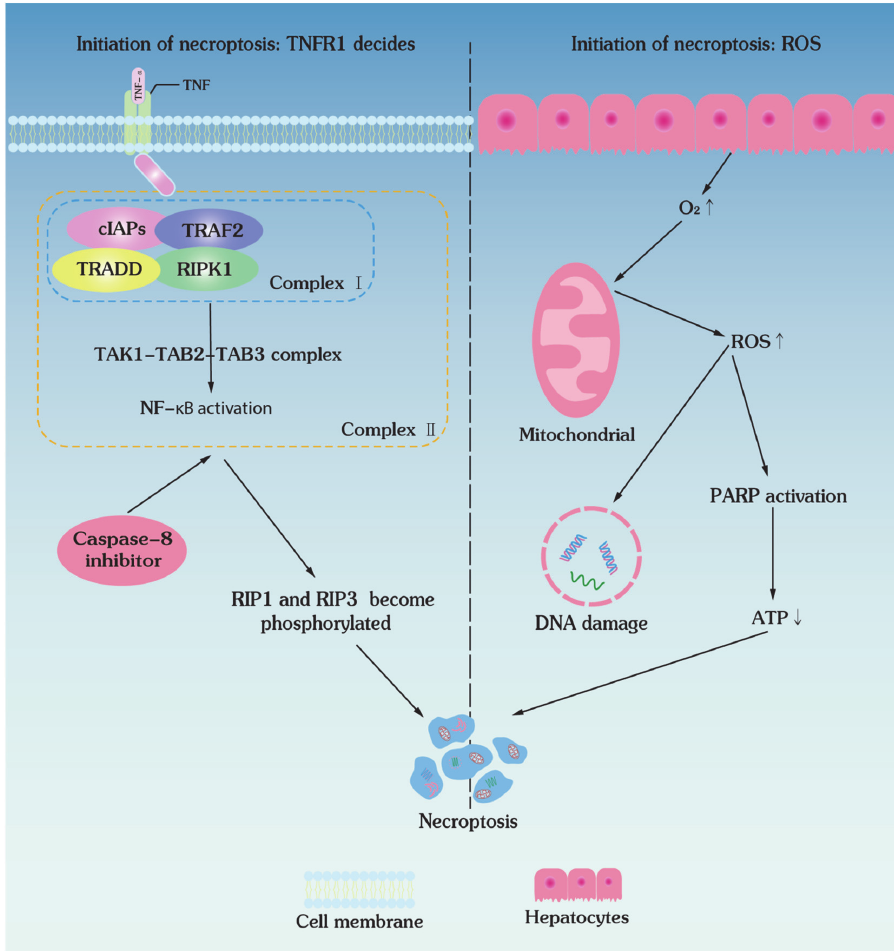
Figure 3. Mechanisms of necroptosis in cells and organs. In mammalian specimens at low-temperature conditions, cellular complex I is formed by TRADD, RIPK1, TRAF2, E3 ubiquitin ligase in cells and activates NF- κ B by recruiting TAB. Due to the dissociation of complex I mediated by caspase-8 inhibitors, RIPK3 oligomerization and phosphorylation result in cell necroptosis; during ischemia–reperfusion injury, organs produce Ca 2+ and ROS, which cannot be cleared. Overloaded ROS activates PARP and leads to cell necroptosis.